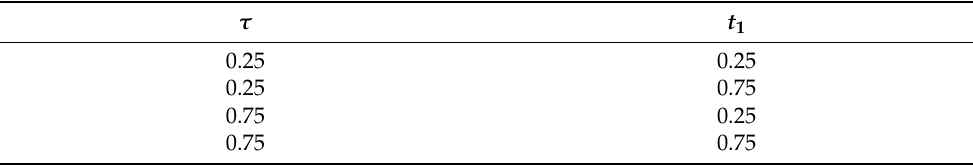
Table 1. Solutions of Equation